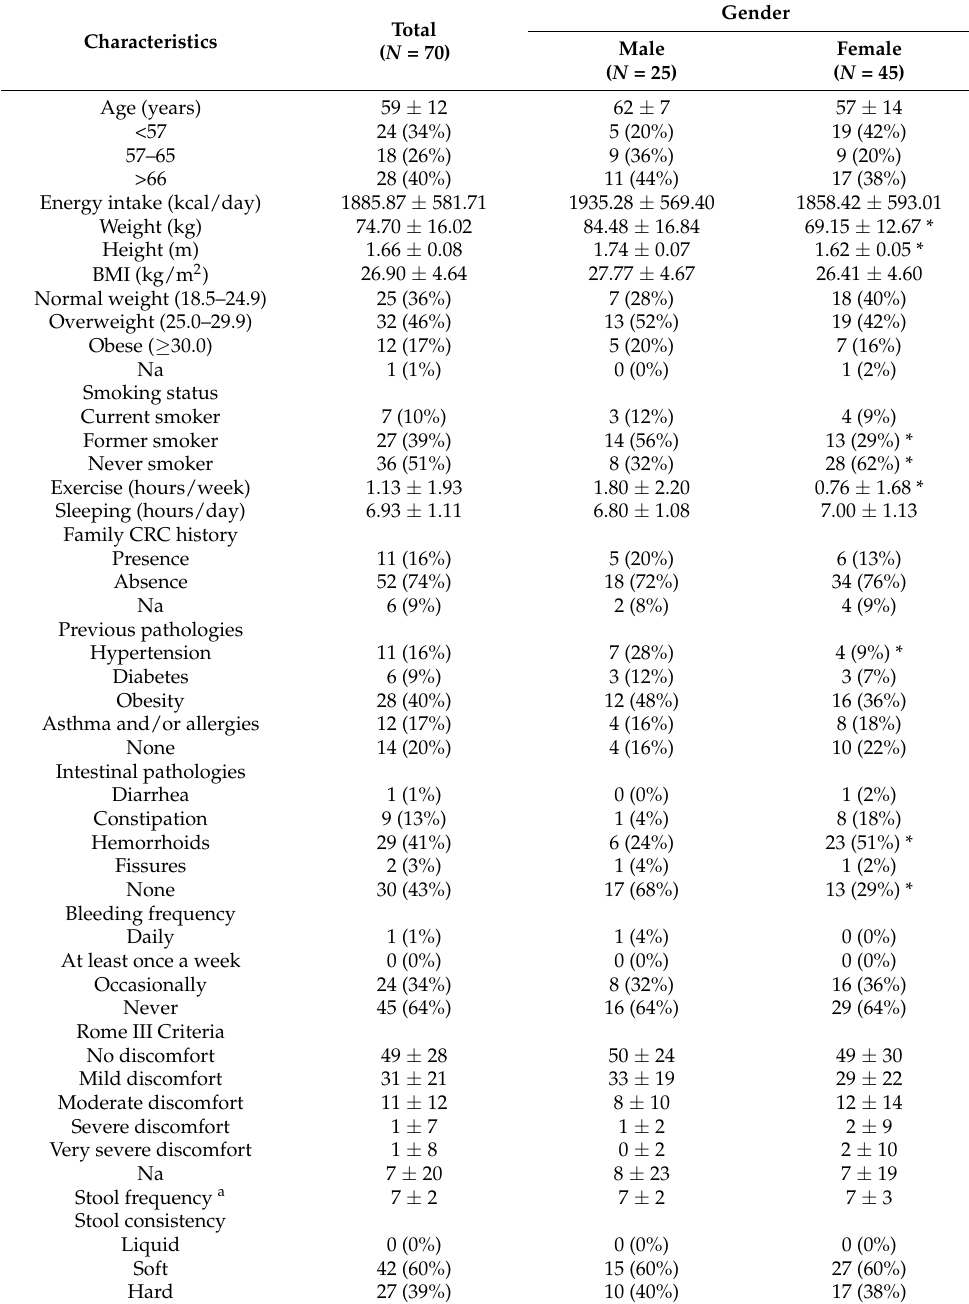
Table 1. General characteristics and description of gastrointestinal functionality, adapted from the Rome III Questionnaire, by